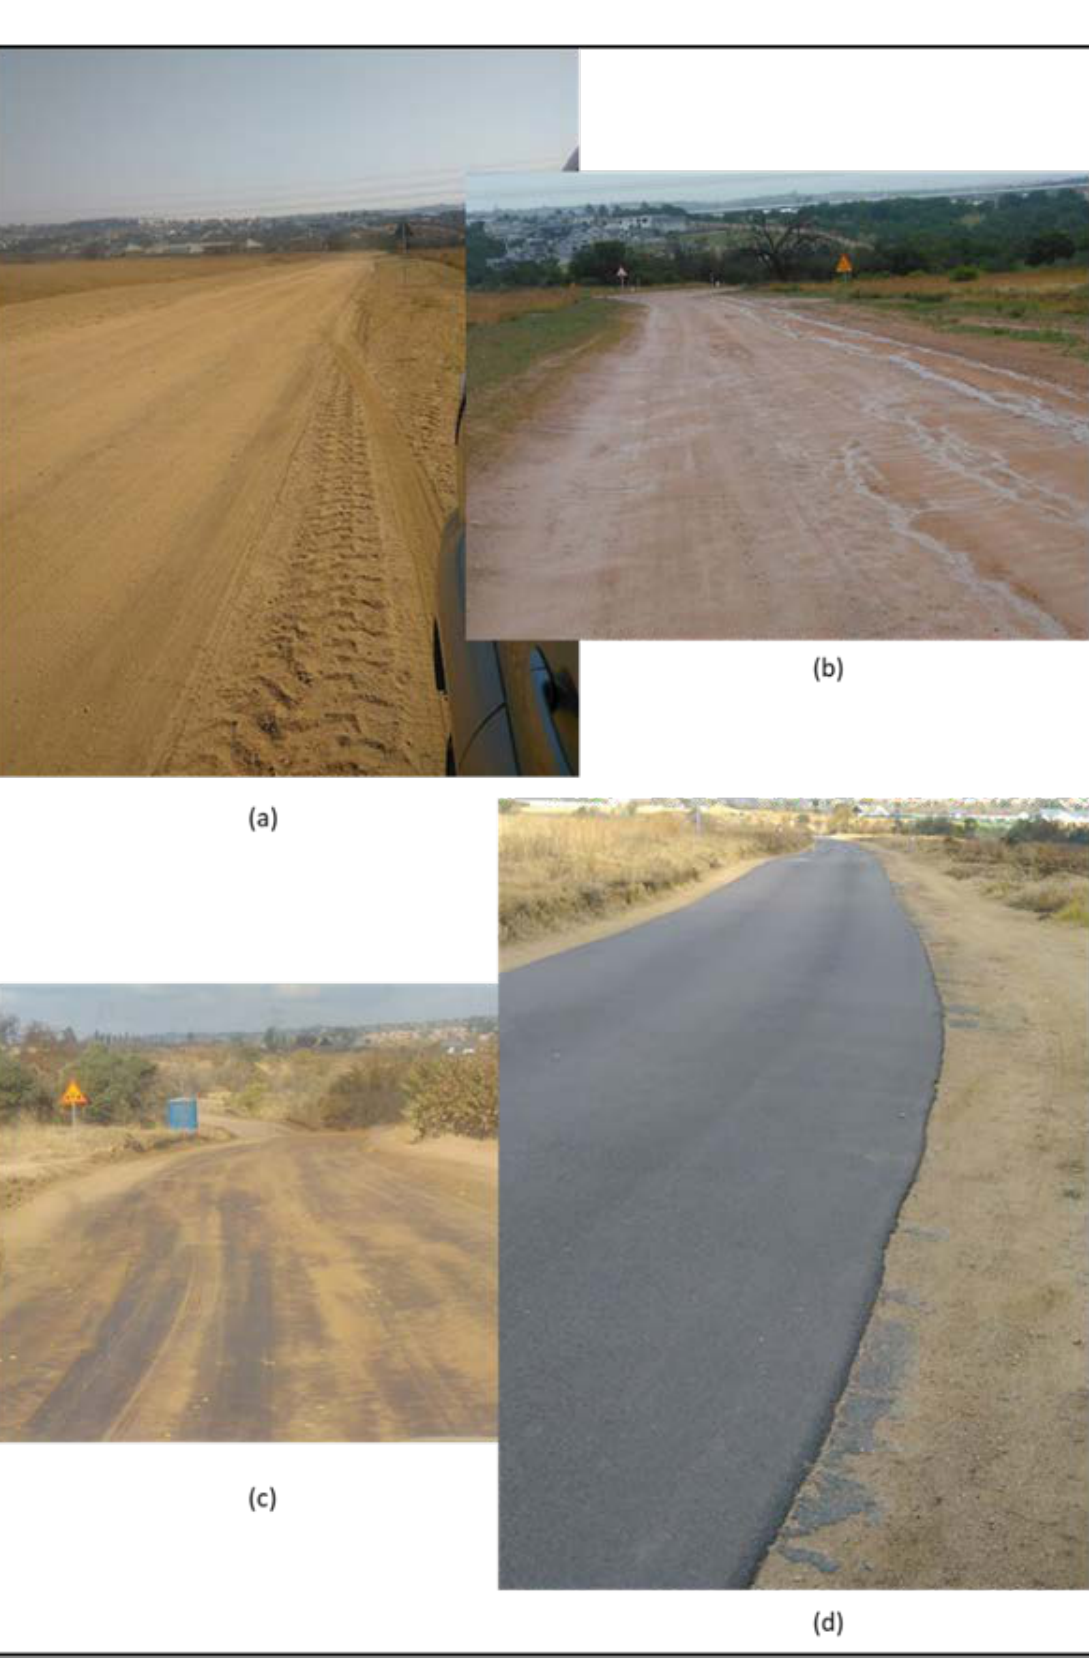
Figure 21. Upgrading of a local access road with ( a , b ) showing the sandy/slippery/muddy conditions prior to upgrading. ( c ) In total, 100 mm of in situ stabilisation with an anionic NME stabilising agent and ( d ) with an ultra-thin fine-graded asphalt surfacing (specified by client).